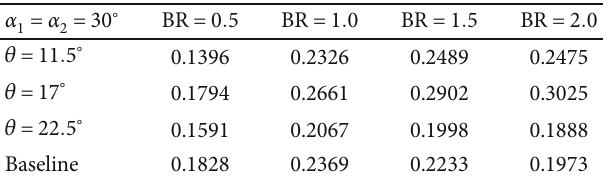
Table 2: Area-averaged fi lm e ff ectiveness for x / d = 0 -25, y / d = − 3 to